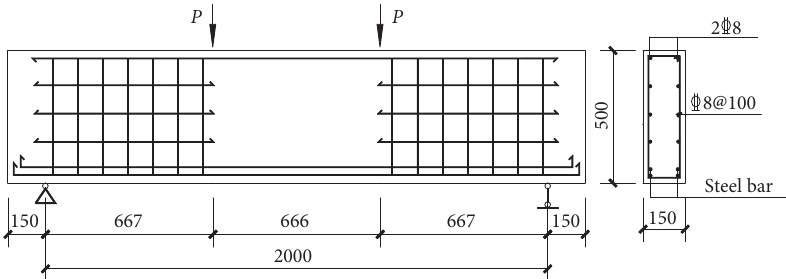
Figure 1: Specimen size and reinforcement drawing (unit: mm).